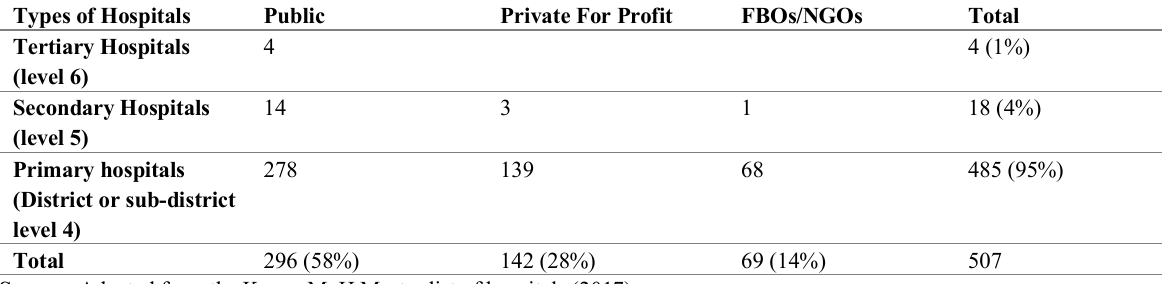
Table 2: National Distribution of Hospitals by Categories of Ownership and Classification of